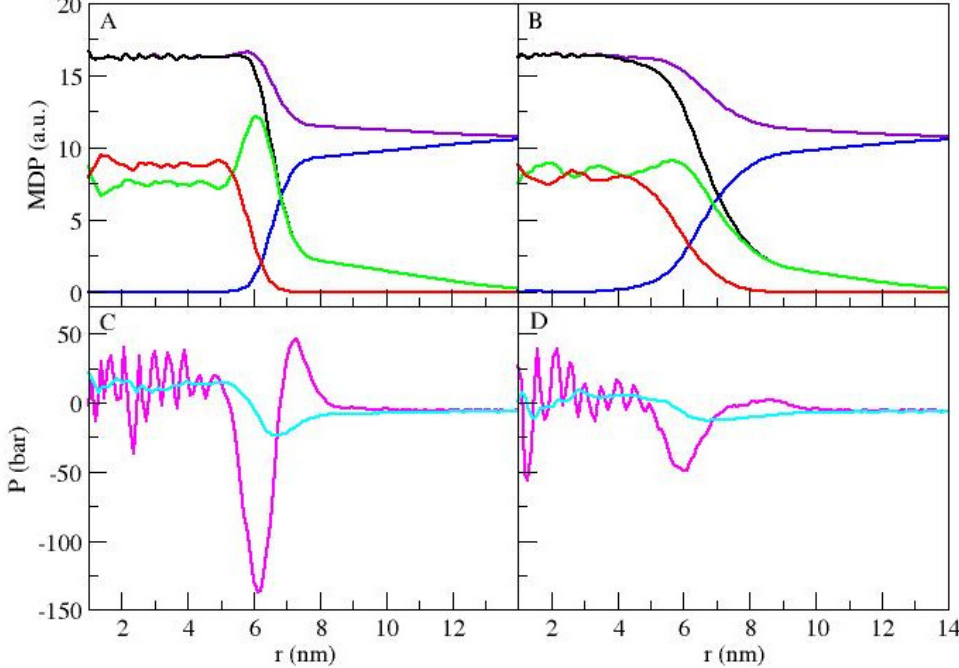
Figure 2. Mass density profiles (MDPs) and pressure profiles as functions of the radius for MS ( A , C ) and MU ( B , D ). For ( A , B ), total density (violet), total polymer (black), water (blue), poly-propylene oxide (PPO, red) and polyethylene oxide (PEO, green) are depicted. For ( C , D ), the normal (cyan) and tangential (magenta) pressure profiles are shown.